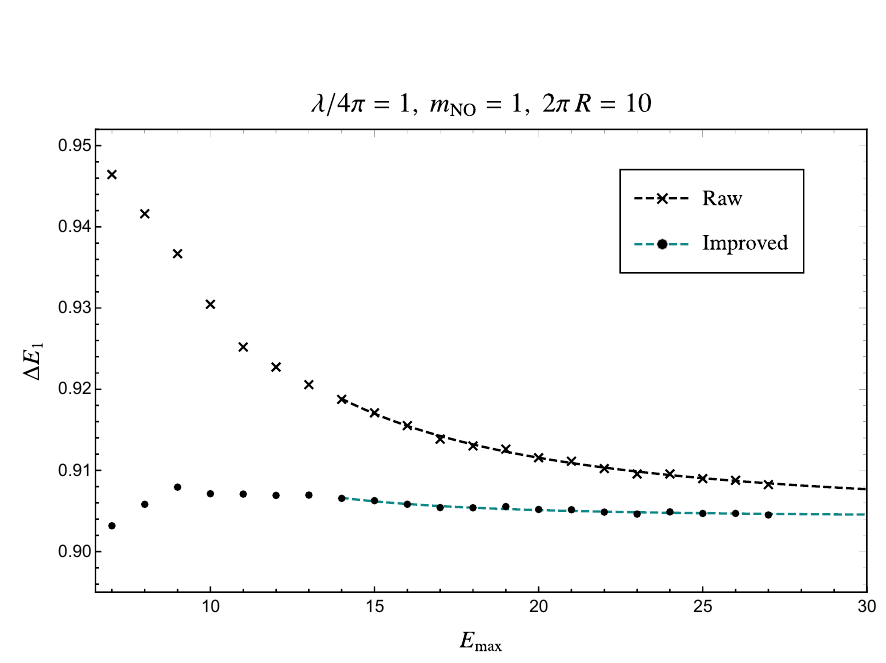
Fig. 2. The ground state excitation energy ∆ E as a function of the (dimensionless) 1 energy cutoff E for both the raw truncated [ crosses ] and improved [ dots ] results. max ≥ 14, the ground state excitation energy of the raw and improved theories For E max are fit to 1 / E 2 and 1 / E 3 , respectively. max max